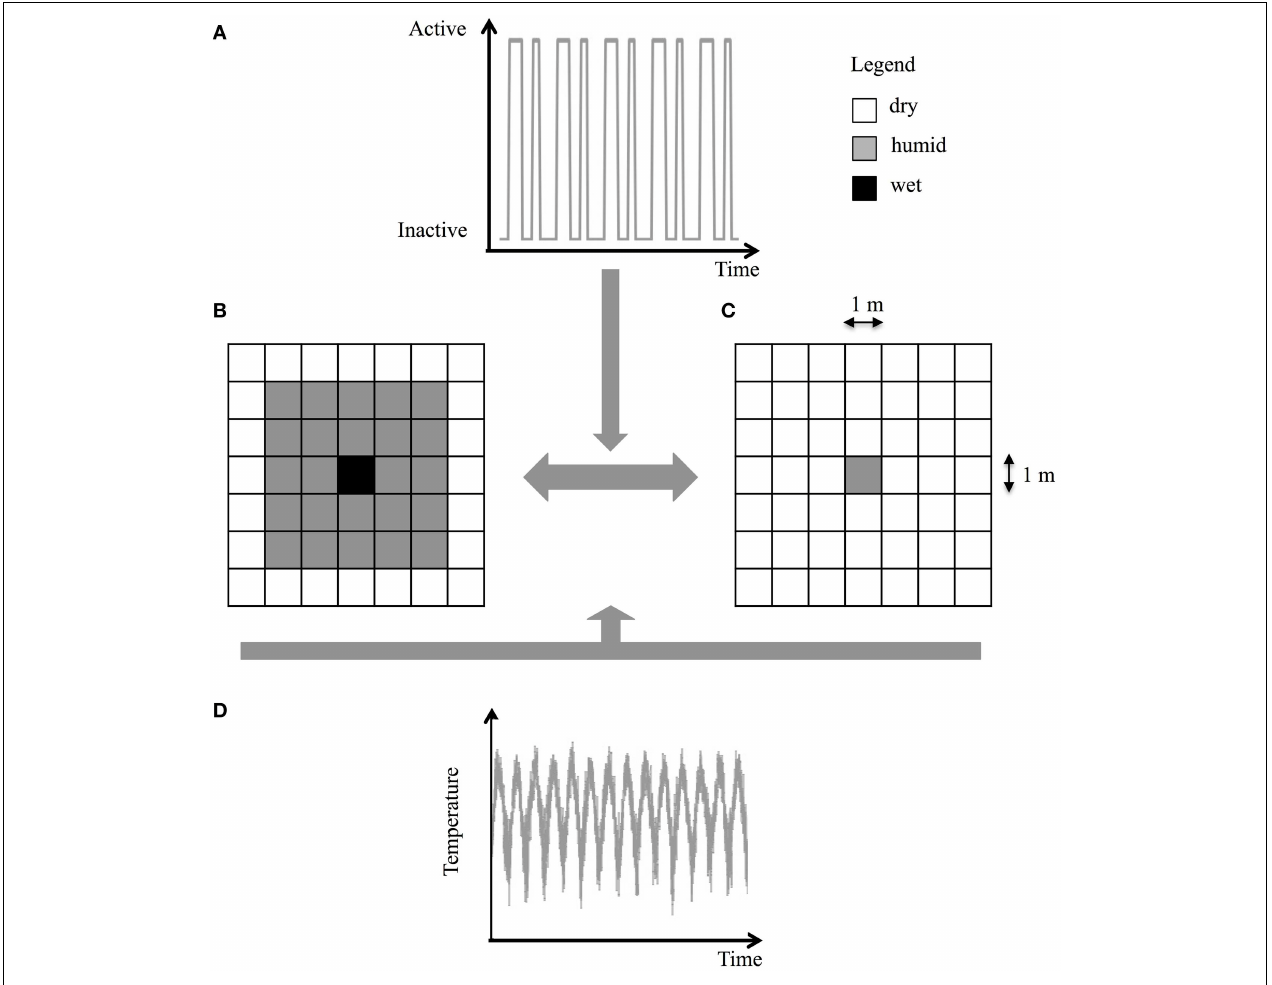
to 7 × 7 m). (A) Activity time series derived from the groundwater flow model, (B) active spring cell, (C) inactive spring cell, and (D) temperature air